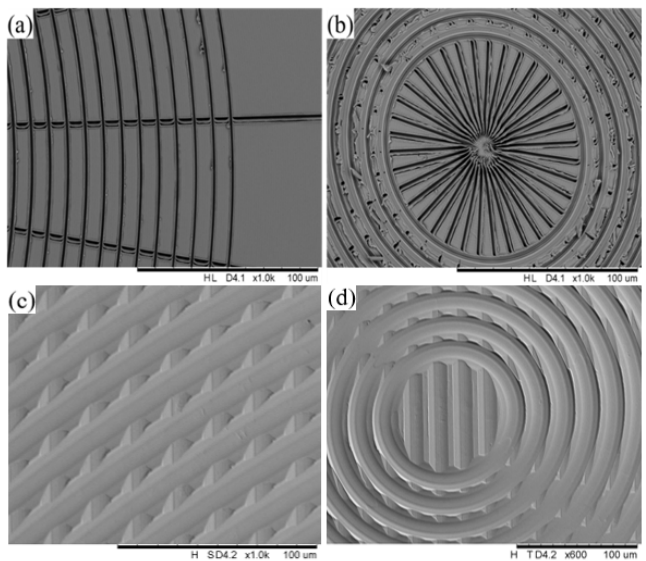
Figure 13. Comparing workpiece machined surfaces by using the sharp tip type and the arc tip type of the diamond tool. Tool wear evolution of the sharp tip type of diamond tool: ( a ) initial machining quality of the workpiece surface by the sharp tip; ( b ) workpiece surface machining quality after tool wear of the sharp tip. Machining quality of the workpiece surface by the arc tip; ( c ) workpiece surface machining quality in the adjacent area; and ( d ) workpiece surface machining quality in the central